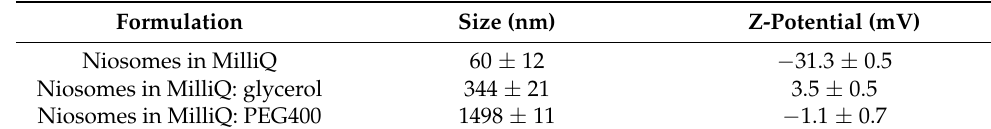
Table 1. Mean size and Z-potential values of niosomes formulated with three different aqueous phases.